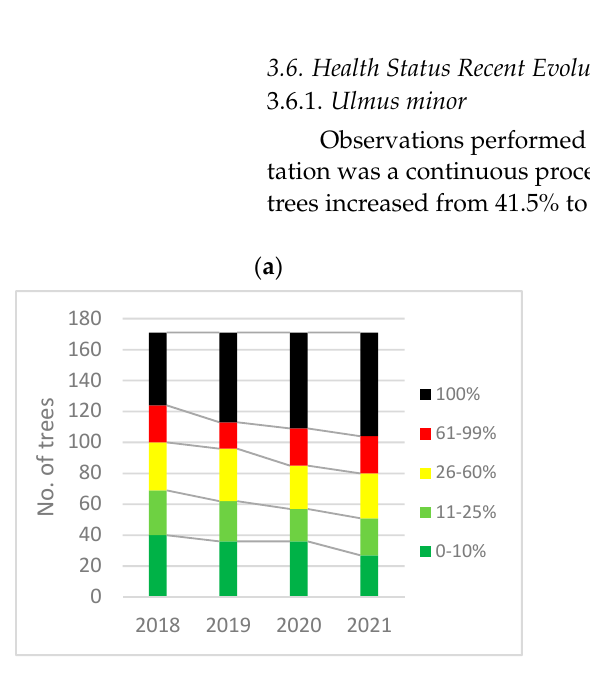
Figure 5. ( a ) Recent defoliation evolution of Ulmus minor (all provenances); ( b ) Different types of individual evolution of U. minor defoliation (tree numbers: 260, 221, 311, and 144). Table 4. Defoliation and diameter of Ulmus minor provenances.